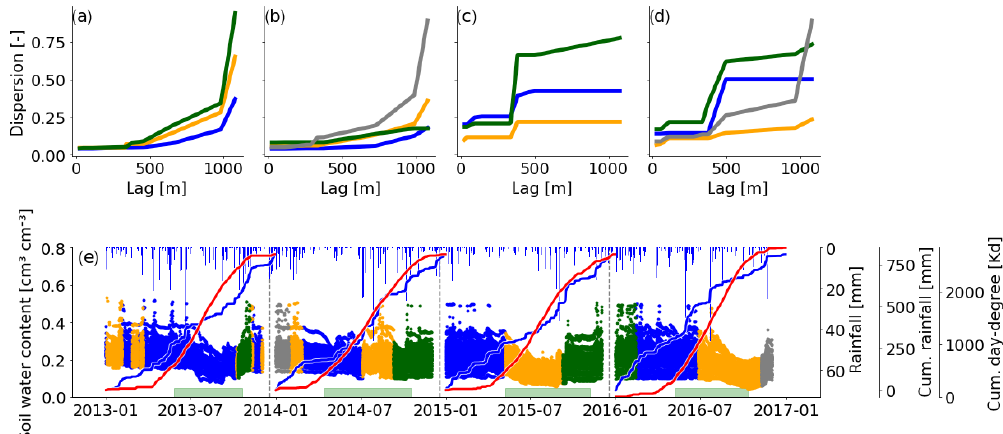
Figure 5. Soil moisture time series of all years in 30cm depth (e) and the respective cluster centroids (a–d) . The colors of the soil moisture data indicate the cluster membership of the corresponding dispersion function of the respective window position and correspond to the color of the cluster centroid (in a–d ). The cumulative rainfalls (blue) and cumulative temperature sums (red) are shown for each year individually. The green bar marks the assumed vegetation period. It covers the dates where the cumulative day-degree sum is > 15% and < 90% of the maximum.